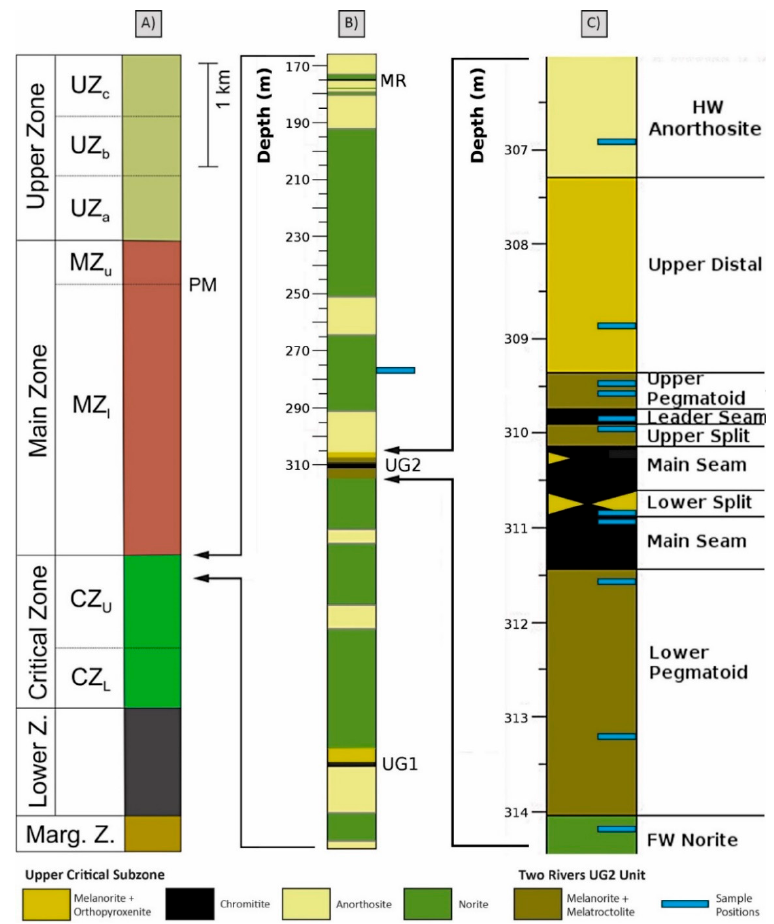
Figure 2. ( A ) Stratigraphic column of the Rustenburg Layered Suite. The colour scheme corresponds to Figure 1C. ( B ) Stratigraphic column of the Upper Critical Zone at the Two Rivers Platinum Mine (based on thicknesses given by [31]). The stratigraphy from the UG2 upwards, marked by an attached depth scale, is adapted on the basis of the core log from drill core BH8039, provided by African Rainbow Minerals. ( C ) Detailed schematic stratigraphy of the subunits of the UG2, as given by the core log from drill core BH8039 and named following the study of Voordouw and Beukes [34]. The indicated depth scales correspond to the actual depth of the drill core BH8039 below surface. Modified after Voordouw and Beukes